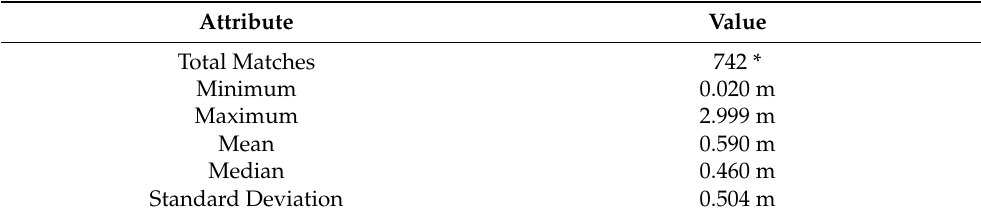
Table 3. Summary statistics for measured tree to predicted tree